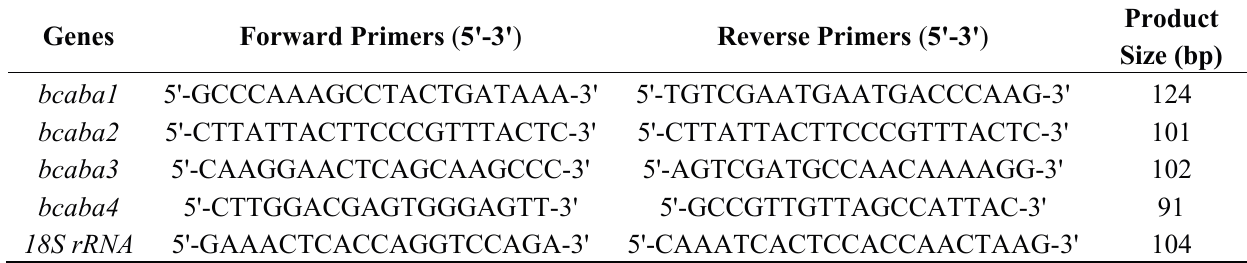
Table 3. Sequences of oligonucleotide primers designed for